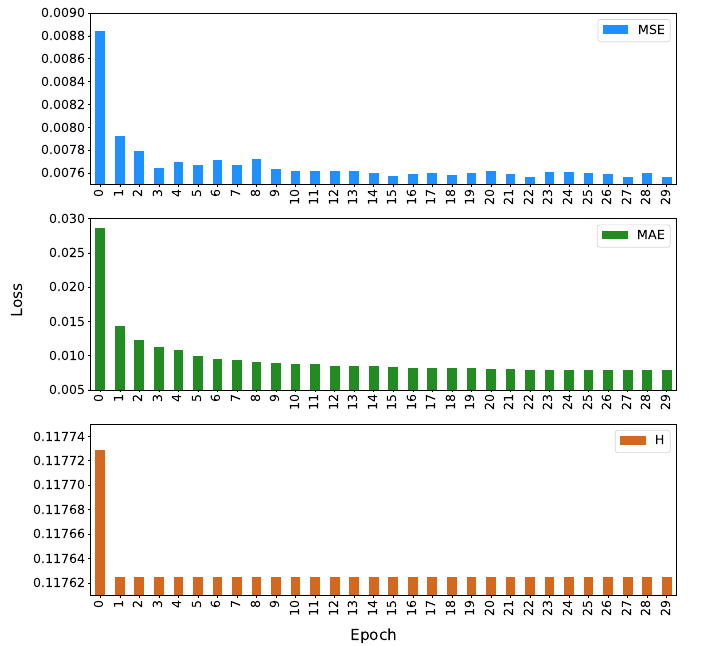
Figure 2. Long Short-Term Memory loss parameter by epochs based on the ASNM-CDX-2009 dataset. Verification of the model with validation data, which constitute the second half of the ASNM-CDX-2009 dataset, allowed collection of the results of its